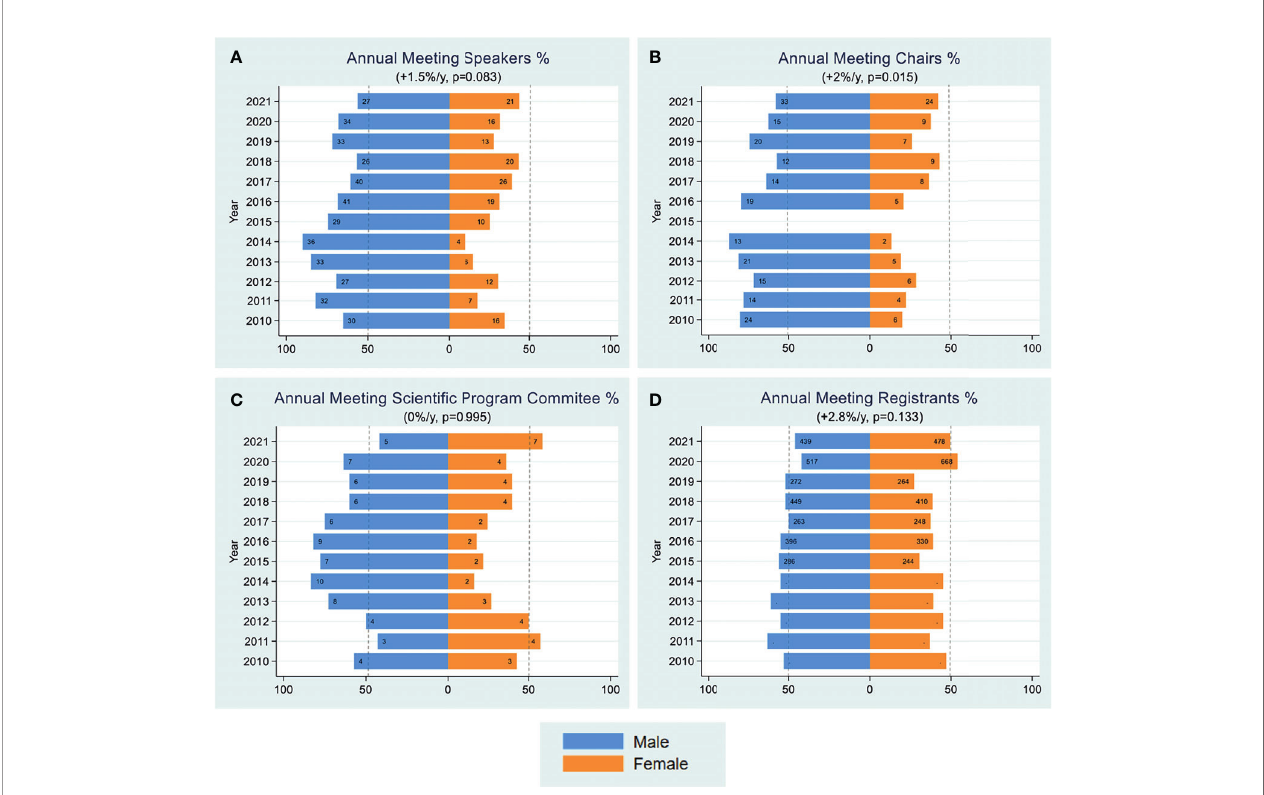
FIGURE 2 | Annual Meeting. Yearly female percentages of annual meeting speakers (A) , session chairs (B) , scienti fi c program committee (C) , and registrants (D) are shown over the period 2010-2021. Percentages were based on actual numbers subjects stating their gender. Average changes per year and p-values (shown in parentheses) were estimated by the slope coef fi cient from a simple linear regression model. Gender data was not collected for annual meeting chairs in 2015. The dotted line represents 50% as a point of reference for